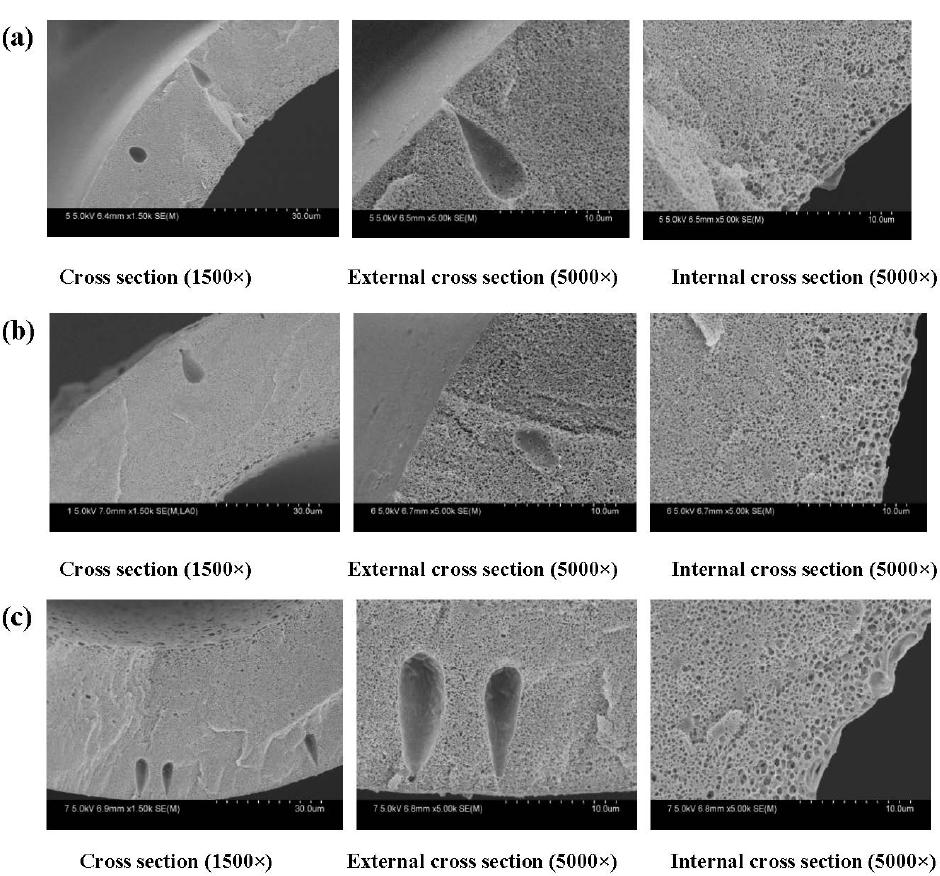
Figure 5. SEM images of different membrane thickness. The inner diameter is 200 μ m. The wall thickness of the PVDF hollow fiber membranes: ( a ) 30 μ m; ( b ) 40 μ m; ( c ) 50 μ m. The preparation parameters of PVDF membranes were shown in Table 1